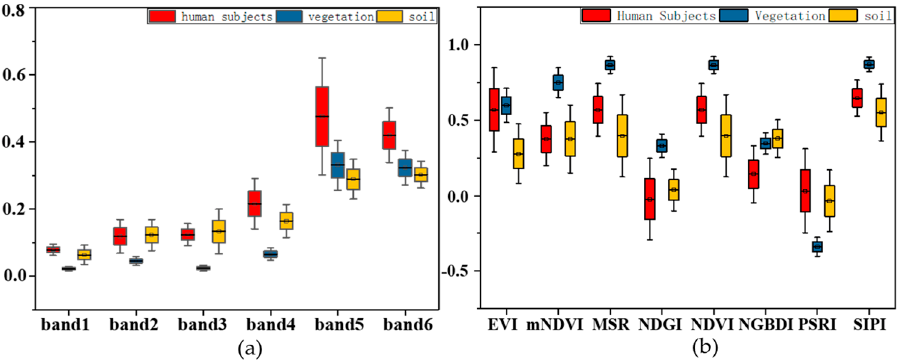
Figure 7. Two kinds of features for 3 typical subjects. ( a ) Reflectivity of six bands, ( b ) Spectral in- dexes.